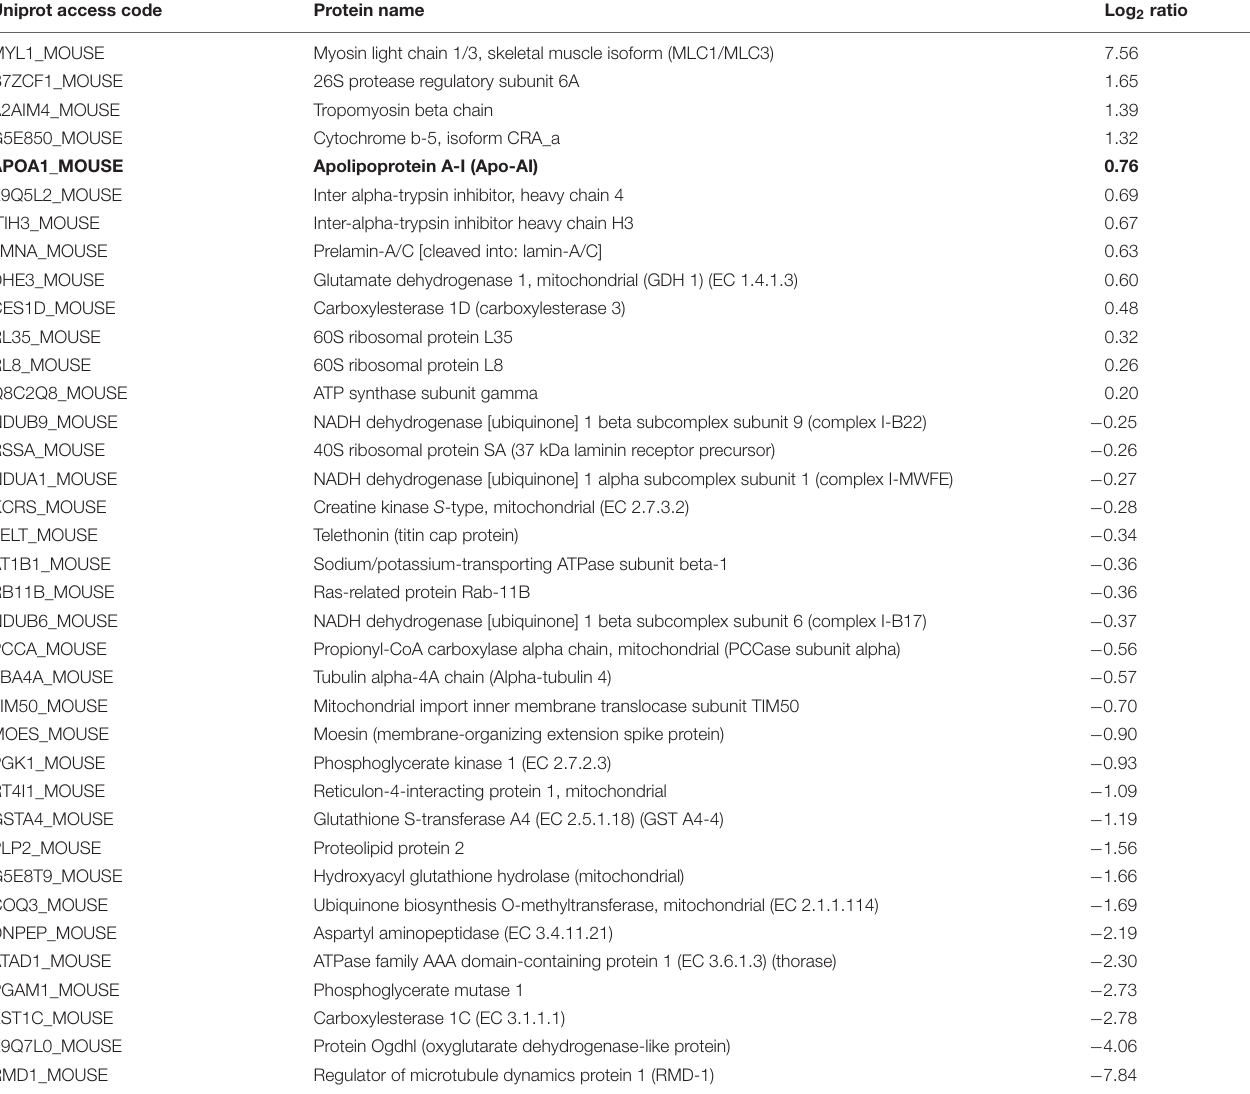
TABLE 3 | Proteins differentially expressed ( P < 0.05) in infarcted mMCP-4 KO mice compared to infarcted WT congeners. Uniprot access